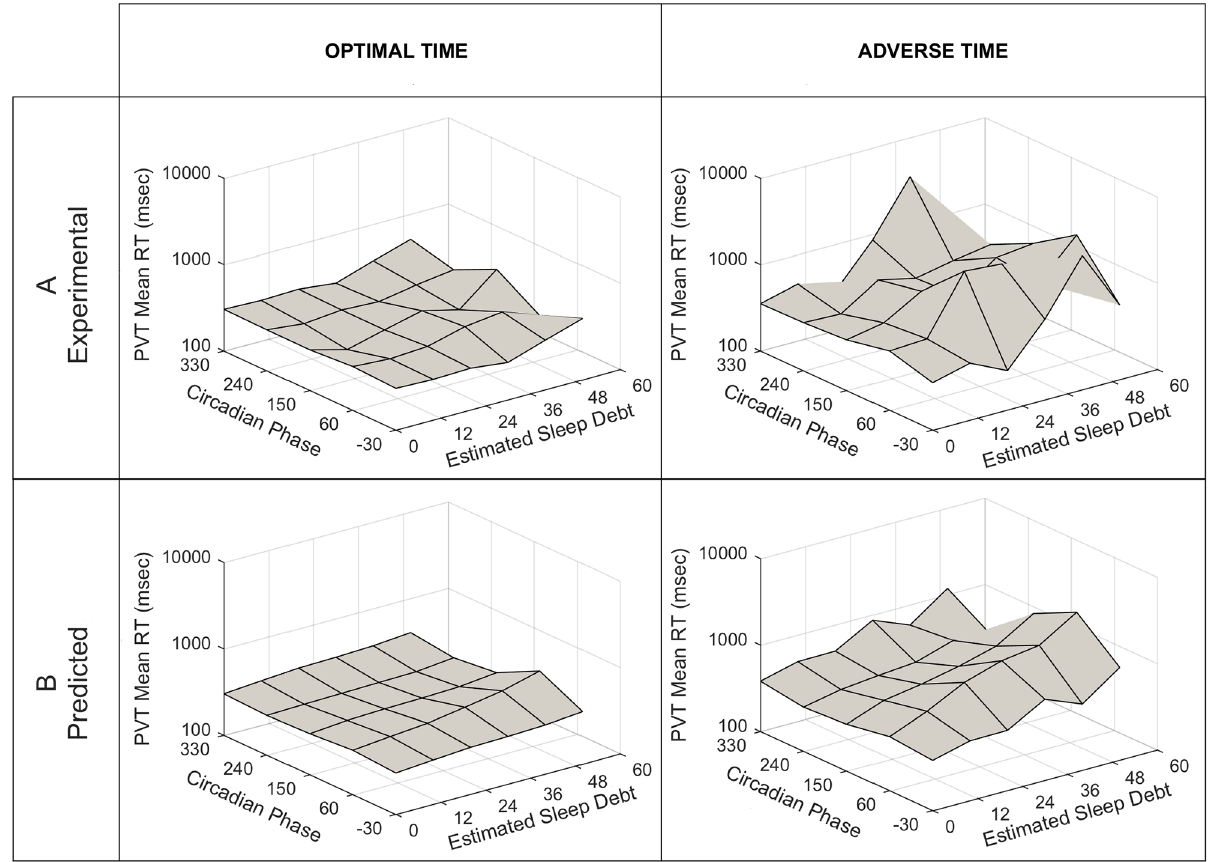
Fig 9. Top Row (A) Actual PVT mean for the experimental data vs. Phase and Sleep Debt . Bottom Row (B) Predicted PVT mean from model vs. Phase and Sleep Debt . Plots show the mean reaction time (RT) on the Psychomotor Vigilance Task (PVT) as a function of Circadian Phase (zero degrees is the fit melatonin maximum) and Sleep Debt (cumulative hours of insufficient sleep opportunity). Left column values are taken during “ Optimal Time ” (defined as hours 2 – 10 after awakening). Right column values are taken during “ Adverse Time ” (defined as hours 20 – 28 after